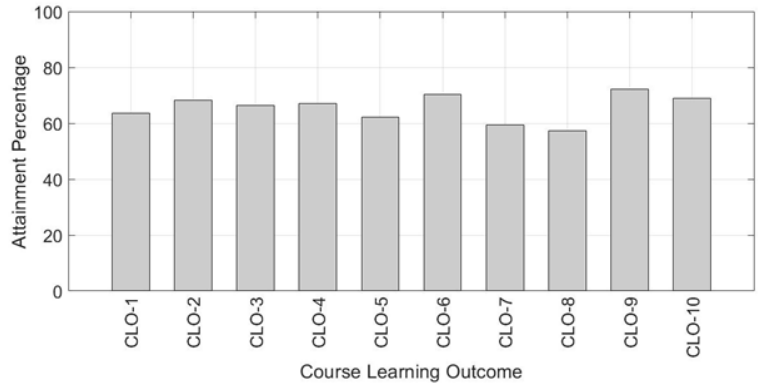
Figure 4. Attainment percentage of the lecture-based